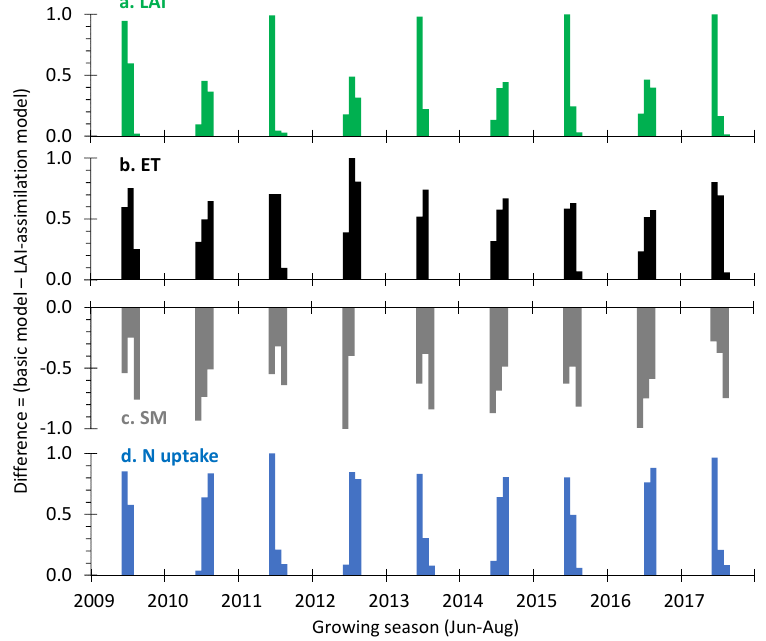
Figure 6. Bias in LAI ( a ) proportionally influenced the models’ partitioning of hydrologic fluxes (as suggested by evapotranspiration (ET) and soil moisture (SM) ( b , c ) and nutrient loads (as suggested by plant nitrogen uptake ( d ). The corresponding values (i.e., difference = basic model—LAI assimilation model) were normalized in a uniform scale (0–1) to show the proportional effect of LAI across different processes. To facilitate a focused assessment, only the growing season watershed average values were included for visualization.